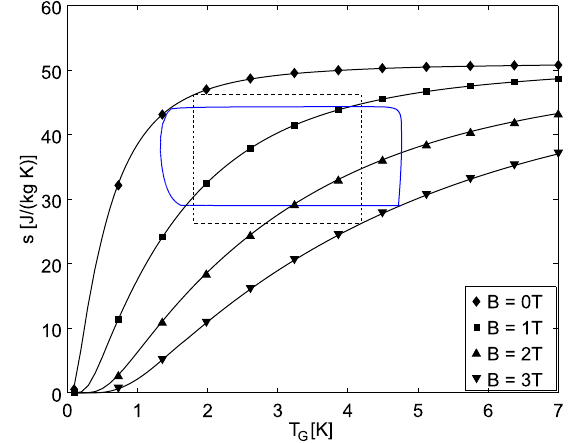
FIG. 5. Carnot cycle (dashed) and thermodynamic cycle taking into account heat exchange conditions on warm and cold sides (blue) of the Hitachi static magnetic refrigerator, without heat losses.